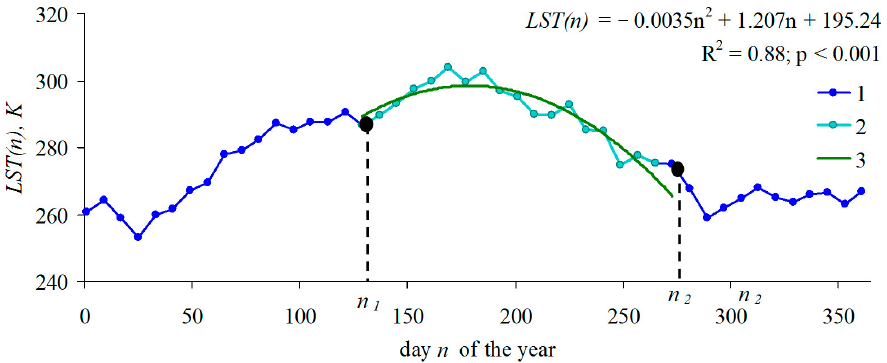
Figure 5. A curve of Land Surface Temperature (LST)( n ) seasonal dynamics, sample plot No. 2 (2014) and the series data processing procedure. 1–a series of 8-day LST time composites; 2–series 1 clipped at the dates of the beginning and end of the growing season, n 1 and n 2 , de- termined for the NDVI( n ) time series; 3–parabolic approximation of LST series. Calculations of parameters of the NDVI and LST seasonal time series and validation of parabolic models using Fisher’s test for all study years and all sample plots are pro- vided in Tables S2 and S3 .